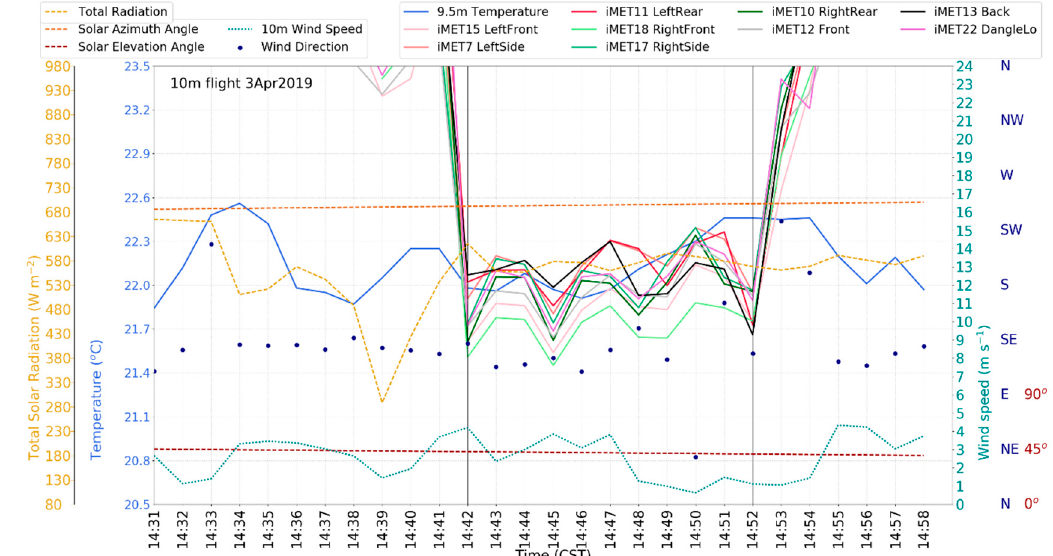
Figure 13. Time series from the 3 April 2019 of the tower temperature at 9.5 m ( ◦ C, solid blue), iMET-XQ temperatures ( ◦ C, various solid colors as shown in the legend), solar radiation (W m − 2 , dashed mustard yellow), solar azimuth angle (degrees, dashed orange), solar elevation angle (degrees, dashed brown), tower wind speed at 10 m (m s − 1 , dotted green), and the tower wind direction at 10 m (degrees, dark blue dots). The two vertical black lines indicate the start and end times of the 10 m flight.